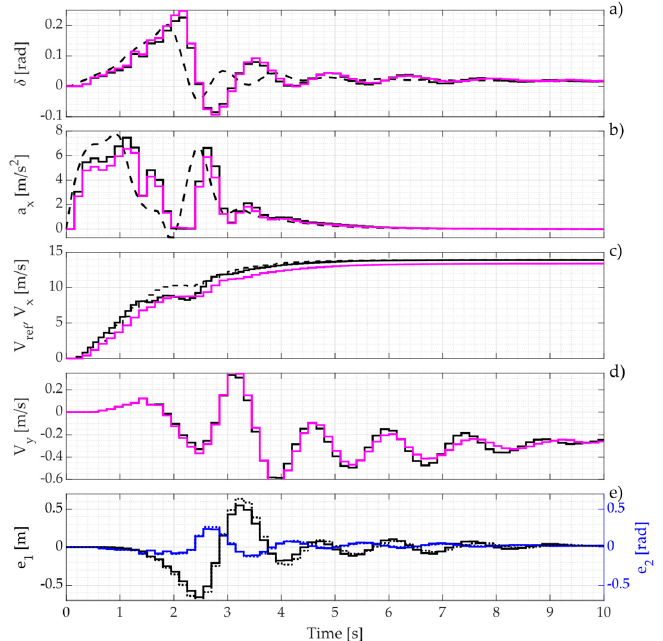
Figure 15. Results obtained during the left turn maneuver in PIL configuration (see Figure 9). Measured vehicle states for Speedgoat (black) and for Raspberry Pi 4B (magenta): ( a ) Front wheels steering angle δ ; ( b ) Longitudinal acceleration a x ; ( c ) Longitudinal speed reference V ref (black, dashed) vs. Actual longitudinal speed V x ; ( d ) Lateral speed V y ; ( e ) Cross track e 1 for Speedgoat (black, solid) and Raspberry Pi 4B (black, dotted) and Relative yaw angle e 2 for Speedgoat (blue, solid) and Raspberry Pi 4B (blue, dotted).